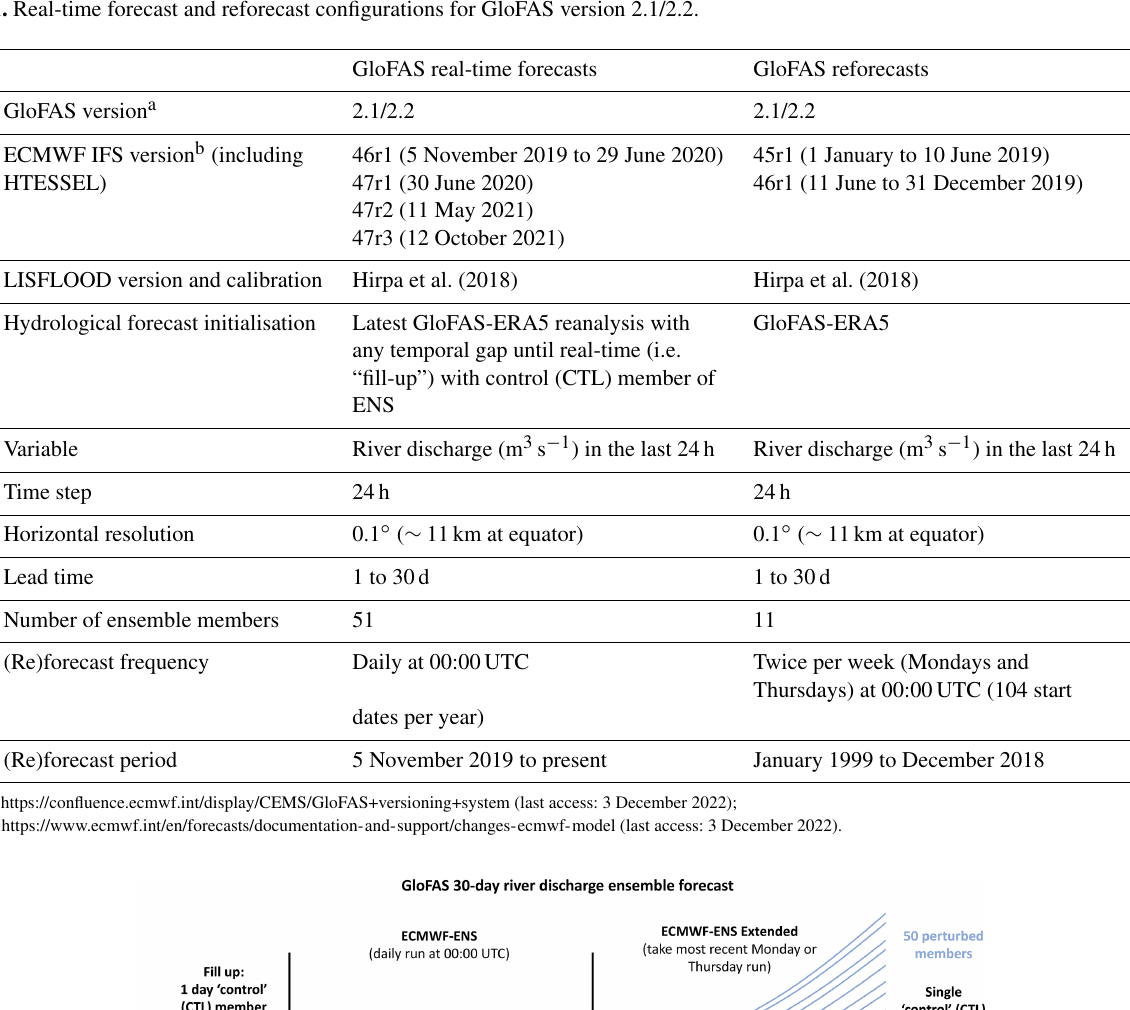
porated into the GloFAS river network (Zajac et al.,